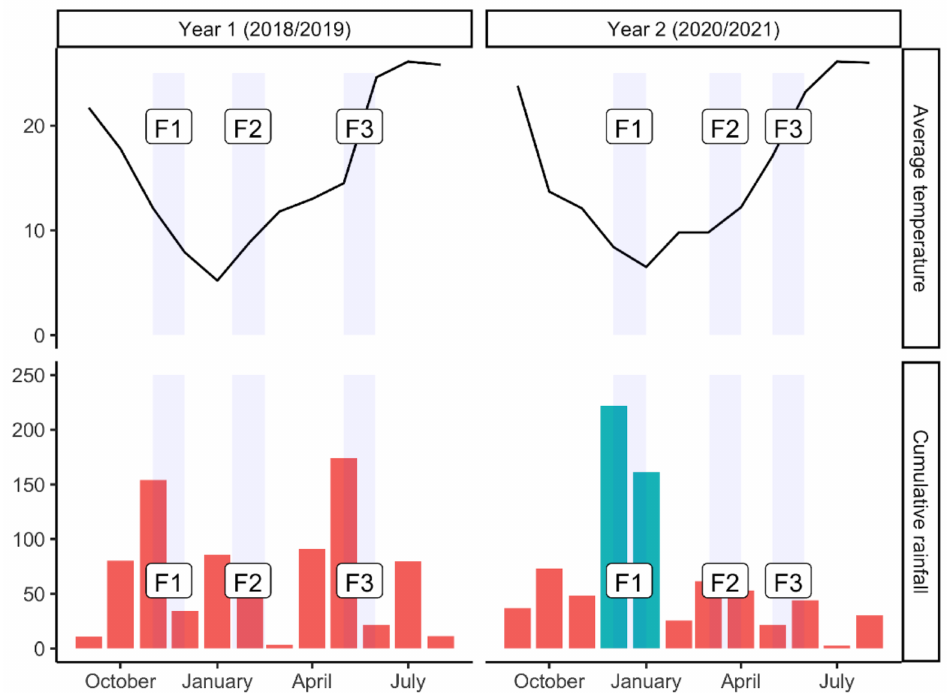
Figure 3. Average monthly temperatures ( ◦ C) and cumulative monthly rainfall (mm) registered in the two cultivation years at the Grotta Marozza (92 m asl) meteorological station. Phenological stage windows are shown as shaded boxes labeled F1 (emergence), F2 (stem elongation), F3 (flowering phase). Cyan-colored bars highlight excessive precipitation events that occurred during the F1 phase in year 2.